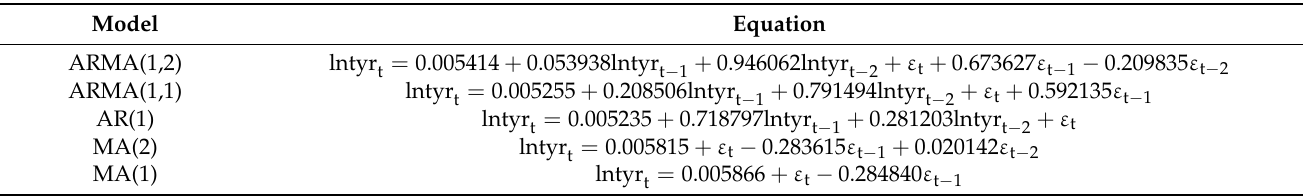
Table 5. Equations of five basic models for fitting top yields of world rice from 1961 to